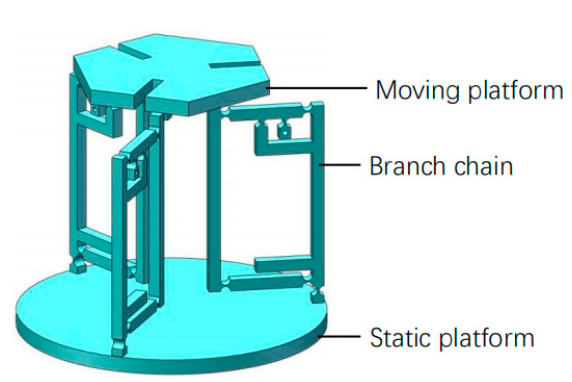
Figure 2. A three revolute-cylindrical-universal (3-RCU) flexible parallel micro operation